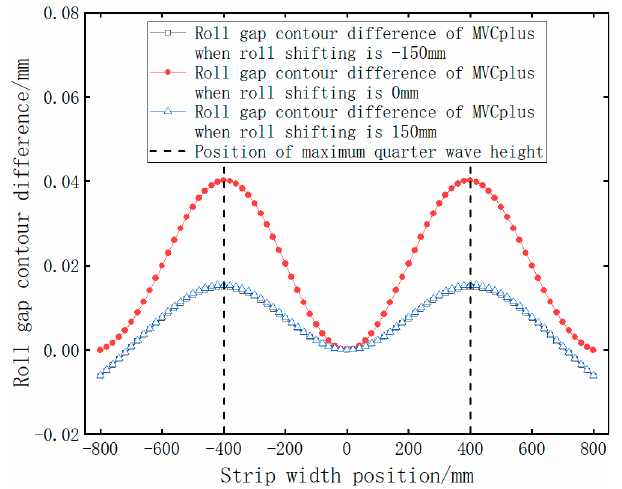
Figure 11. Roll gap contour difference between MVCplus and CVC.